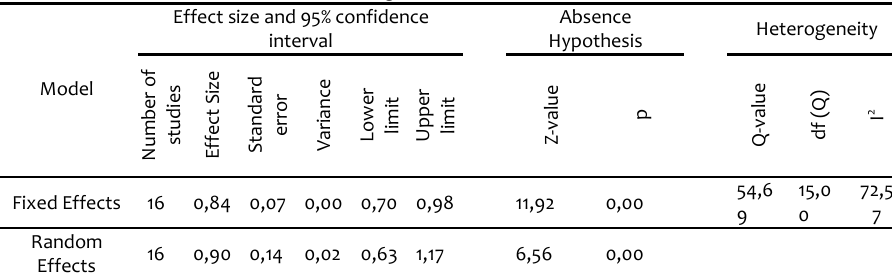
Table 4. Meta-analyzes effect model values of included studies, homogeneous distribution value, average effect size, and confidence intervals Effect size and 95% confidence interval